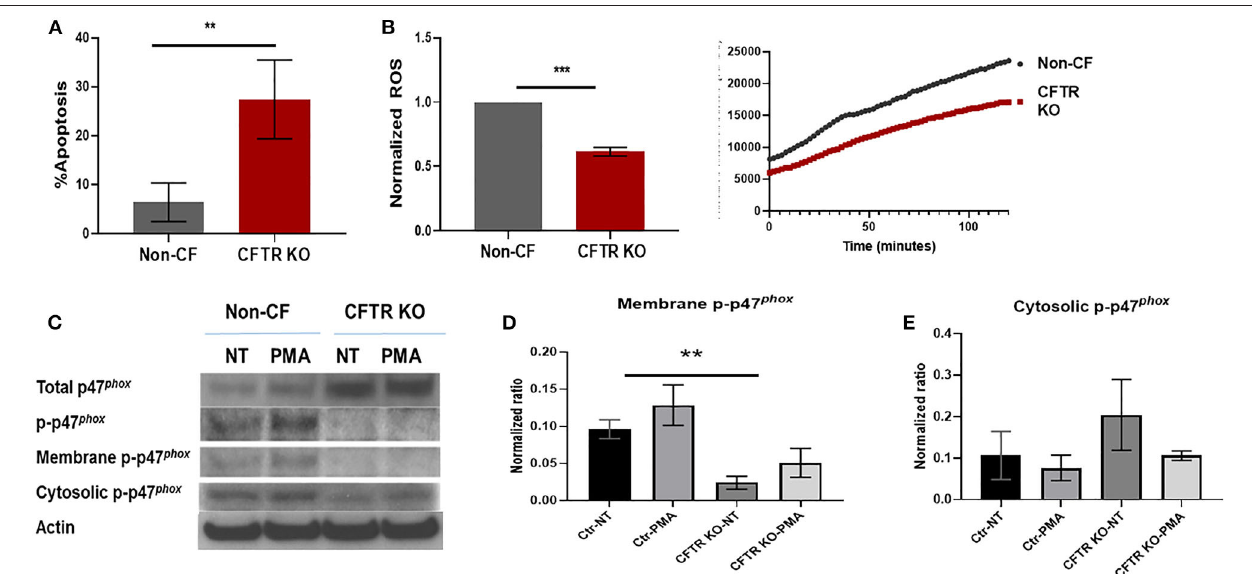
FIGURE 3 | CFTR KO alters macrophage stability and ROS production. (A) Summed apoptosis as measured by flow cytometric detection of Annexin V in CFTR KO and non-CF MDMs, n = 4, mean ± SD. (B) Summed end-point analysis of maximum 2h ROS production in response to PMA. ROS shown as ratio of max ROS normalized to non-CF. Representative time course of ROS production also shown. n = 3, mean ± SD. (C) Western blots of total, phosphorylated, and membrane and cytosolic fractions of phosphorylated p47 phox in non-CF and CFTR KO MDM lysates in response to no treatment (NT) or PMA exposure. Actin shown as loading control. Summed densitometry of western blots for (D) membrane, n = 3 and (E) cytosolic fractions of phosphorylated p47 phox , n = 4, in non-CF and CFTR KO MDMs stimulated with PMA, mean ± SD. ** p < 0.01, *** p < 0.001, via unpaired t -test for (A,B) and one-way ANOVA for (D,E)